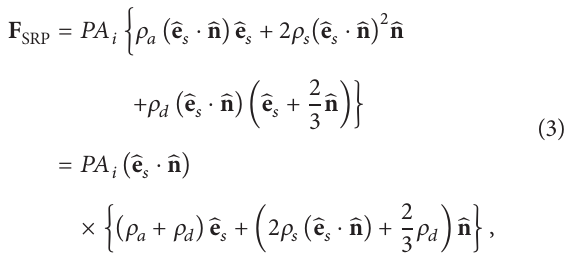
Figure 1: Solar radiation pressure due to a finite solar disc.